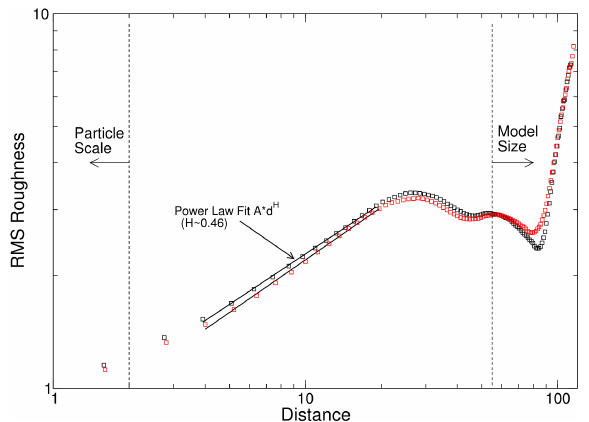
Figure 9. Log–log plot of the height–height correlation function of the two surfaces of a single fracture. Red and black symbols show the rms height differences calculated for each distance bin for the two surfaces. The straight lines are fitted to the linear section of the data in log–log space, showing a power-law dependence.